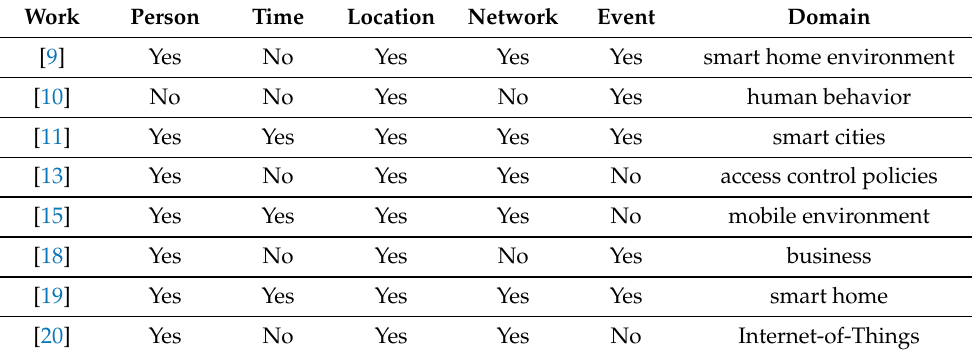
Table 1. Context information in the analyzed